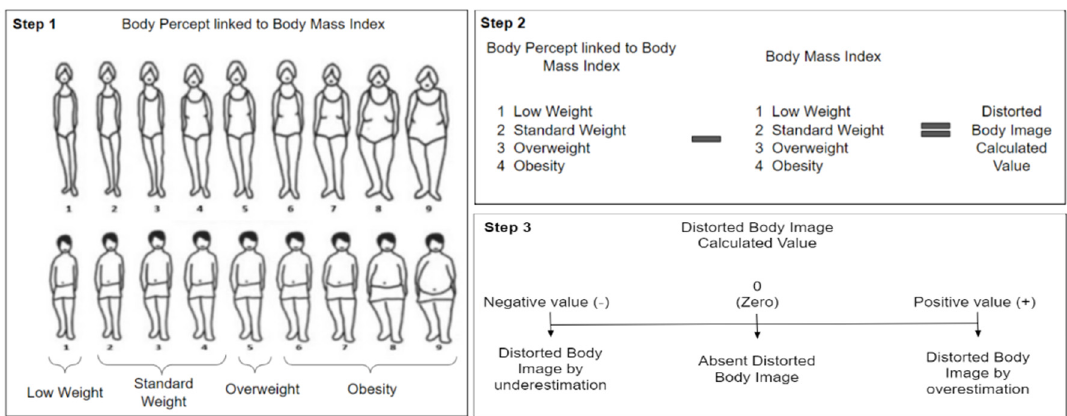
Figure 2. Distorted Body Image Assessment.